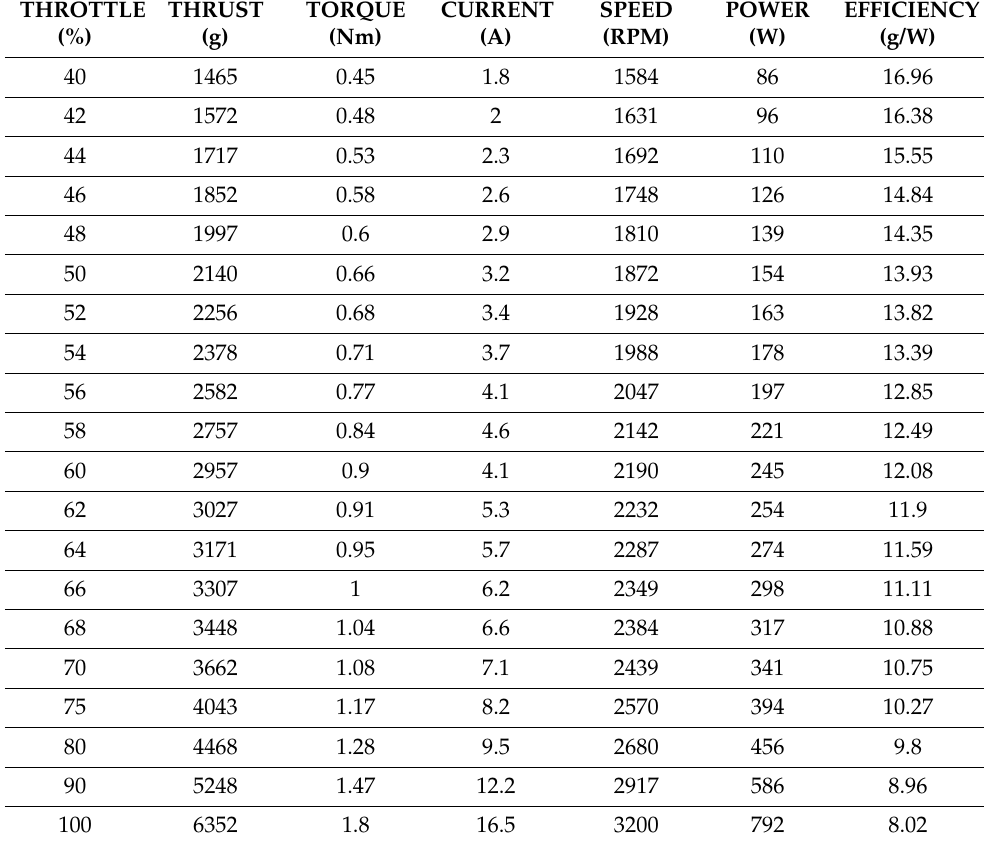
Table 3. Technical specifications of the motor U88II-KV 85™, manufactured by T-Motors™.